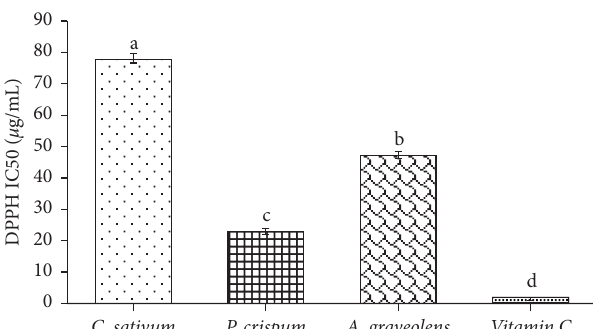
Figure 4: Antiperoxidative activity of different plant extracts. Amounts are mean ( n � 6) ± SE. bars followed by different lower- case letters (a–d) which are significantly different ( p < 0 .